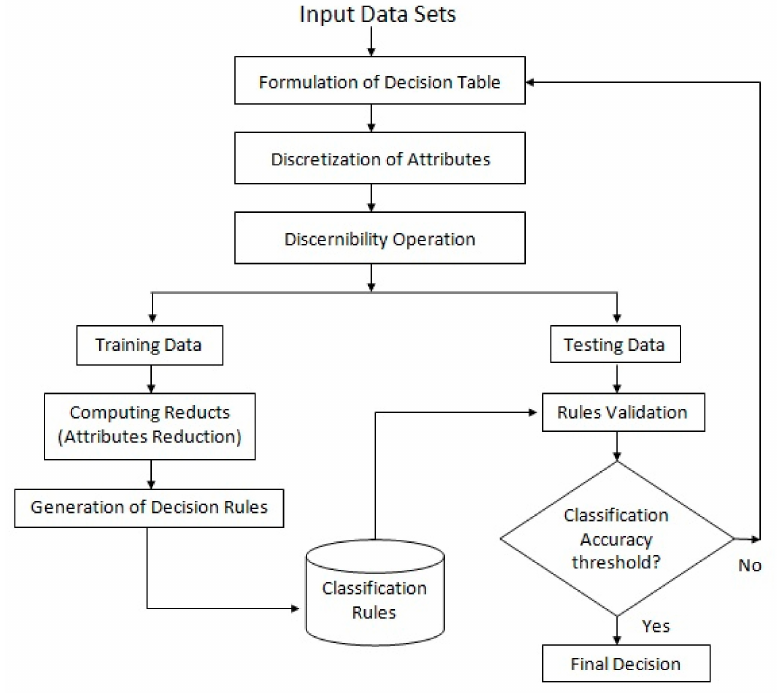
Figure 2. The flow chart of generating classification